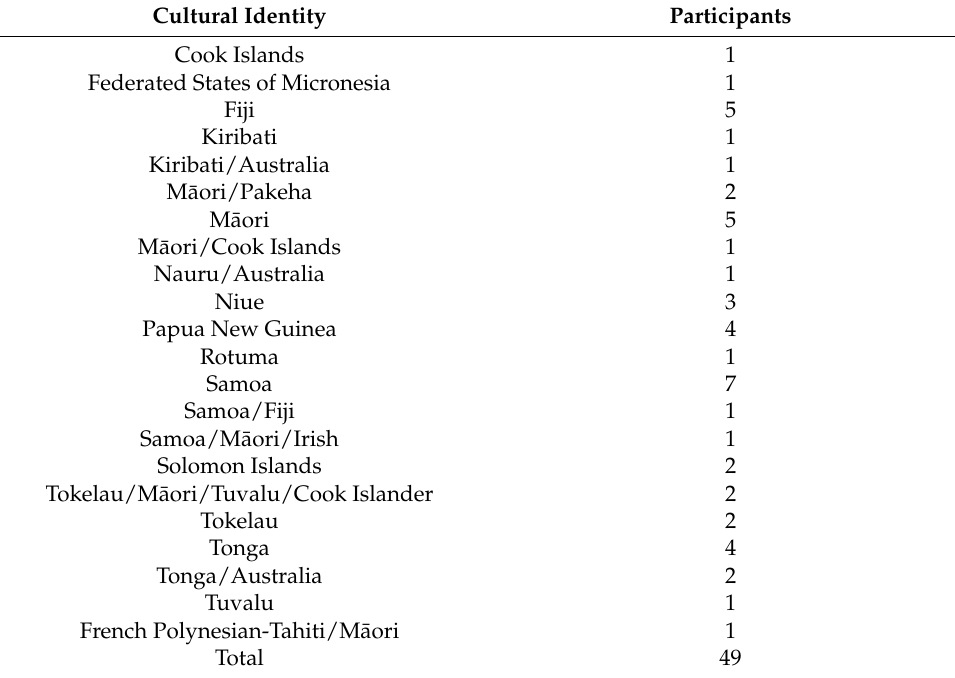
Table 1. Cultural identity as reported by participants in the interviews *.